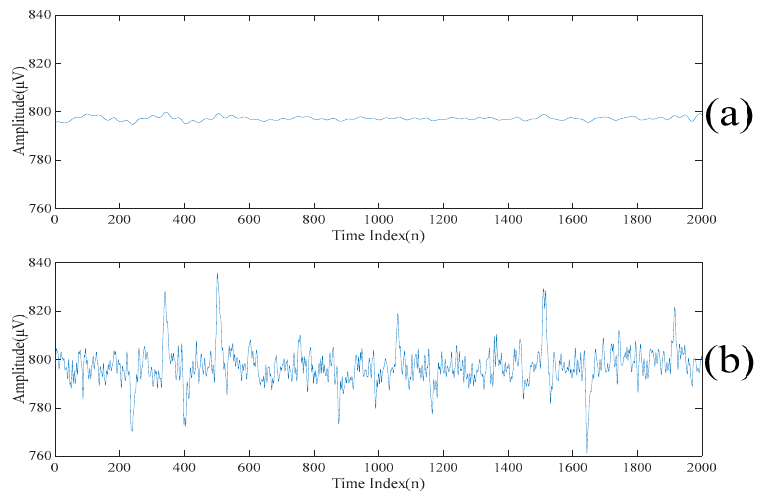
Figure 7. ( a ) The first scale of the electroencephalogram. ( b ) The residue of the electroencephalogram.